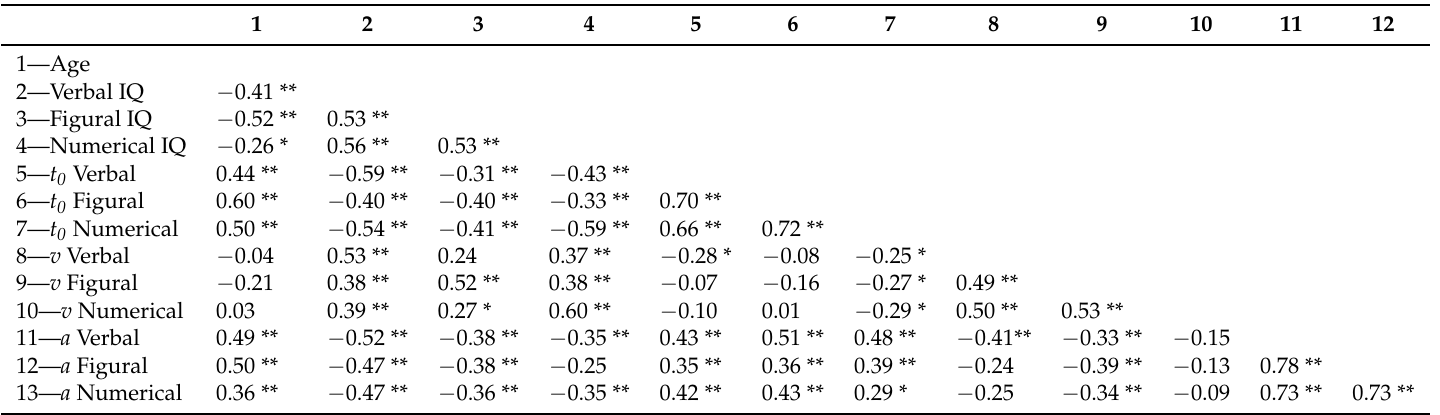
Table 6. Correlation matrix of the variables used for the content-domain specific mediation